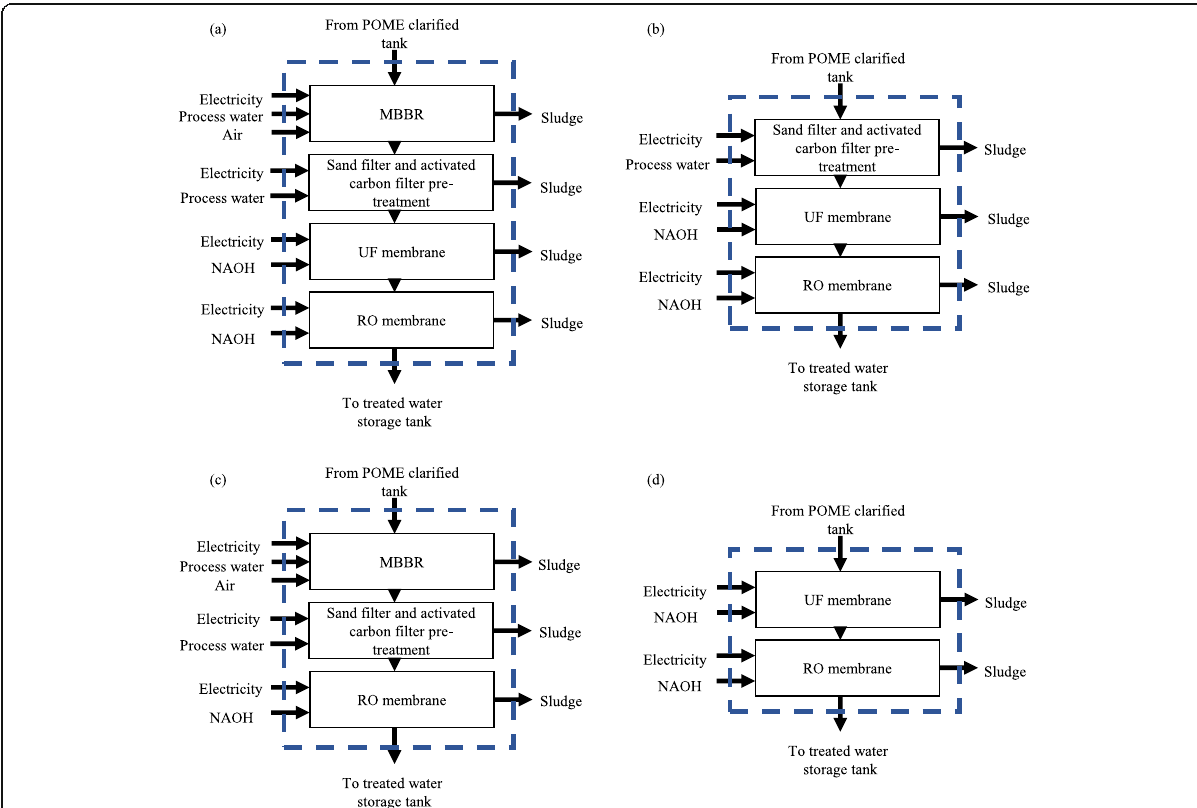
Fig. 2 Display of process flowchart of each combination with a system boundary for Combination I, b system boundary for Combination II, c system boundary for Combination III, d system boundary for Combination